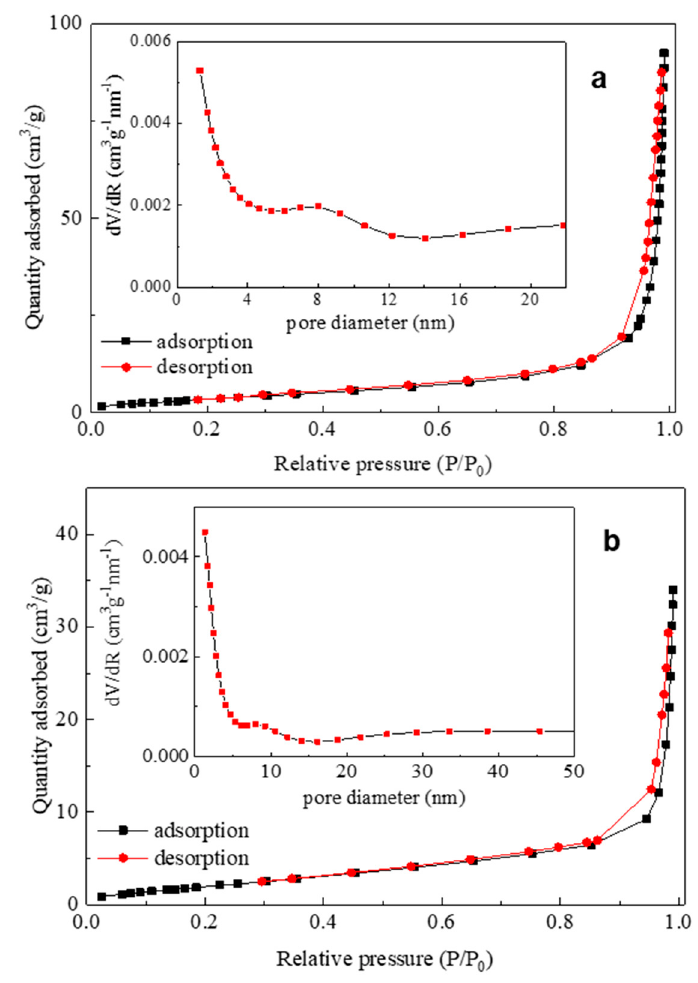
Figure 4. N 2 adsorption–desorption isotherm of the samples: ( a ) flower-like Bi 2 WO 6 , ( b ) nanoparticle Bi 2 WO 6 . The insert shows the pore size distribution. Table 3. Brunauer–Emmett–Teller (BET) parameters of the Bi 2 WO 6 samples at various temperatures. Surface Samples